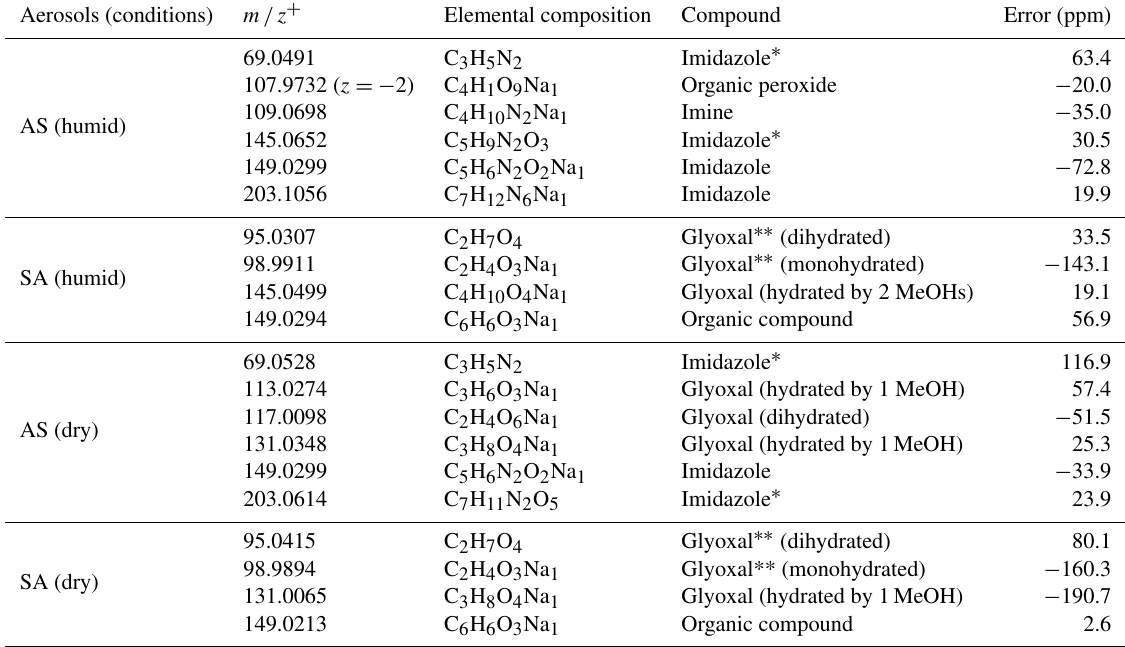
Table 2. Elemental compositions of glyoxal and other organic–inorganic compounds at 180min irradiation time (UPLC-Q-TOF-MS positive- mode